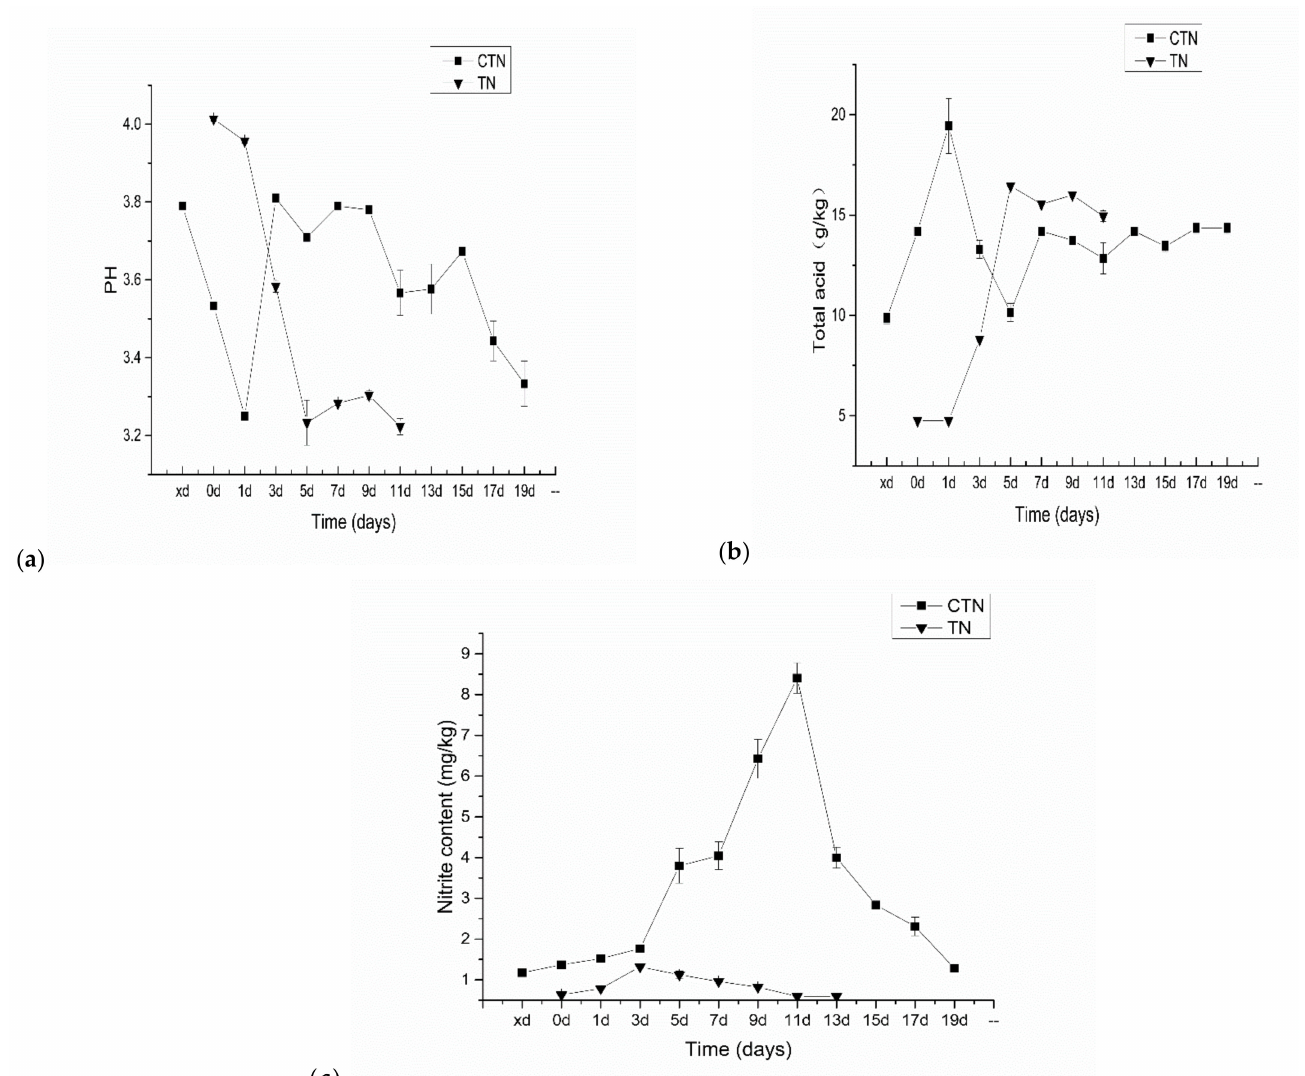
Figure 4. Changes in physicochemical indexes during TN and CTN fermentation: ( a ) pH, ( b ) total acid, ( c ) nitrite content. TN refers to the enhanced fermentation tomato sour soup sample; CTN refers to the traditional tomato sour soup